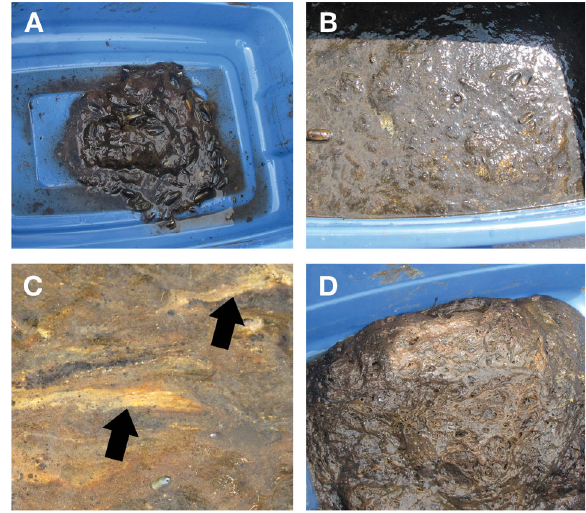
Fig. 1. Flocculent matter retrieved by grab sampling under a hard-bottom aquaculture site in Newfoundland, Canada. Visually distinct material is shown, including (A) dark/black and (B) brown flocculent matter, (C) suspected bacterial mat remains (indicated by arrowhead) on top of flocculent matter and (D) ‘gaseous’ flocculent